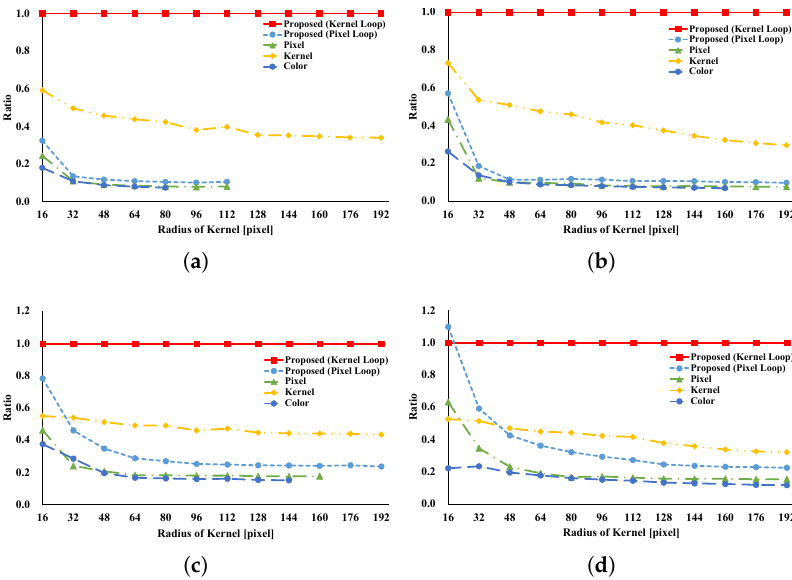
Figure 19. The speedup ratio for randomly-kernel-subsample adaptive Gaussian filtering (RKS-AGF) with respect to the kernel radius of FIR filtering. ( a ) 1/4 subsample in weight computation; ( b ) 1/16 subsample in weight computation; ( c ) 1/4 subsample in LUT; ( d ) 1/16 subsample in LUT. If the ratio exceeds 1, the given pattern is faster than the kernel loop